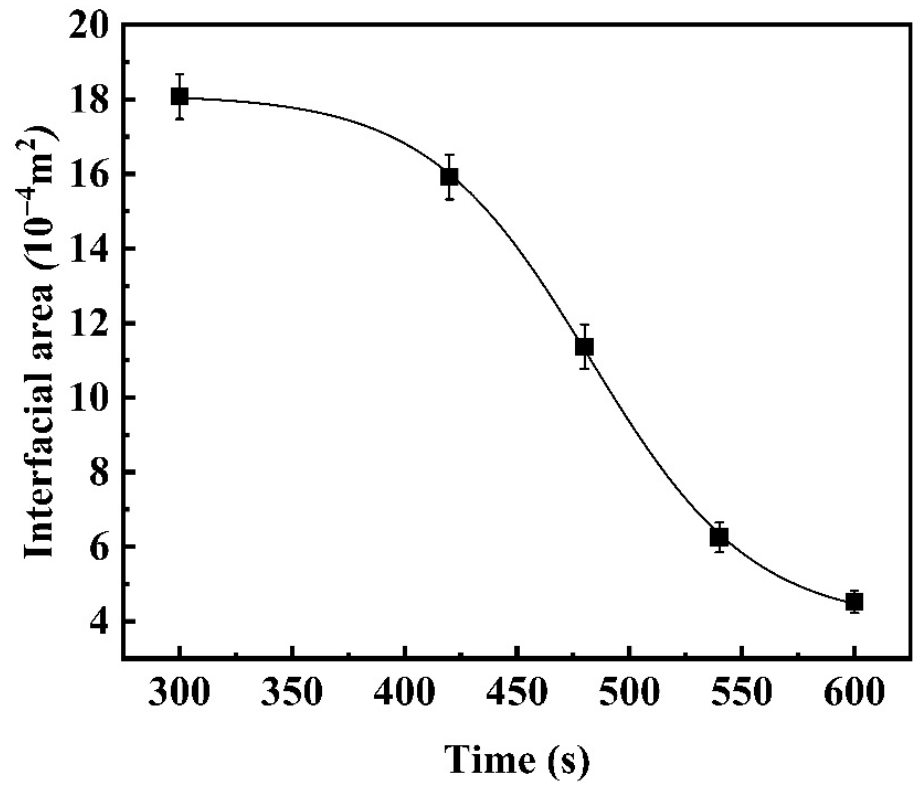
Figure 6. Change of interfacial area during the reaction of Fe-5Al alloy with high SiO 2 slag.